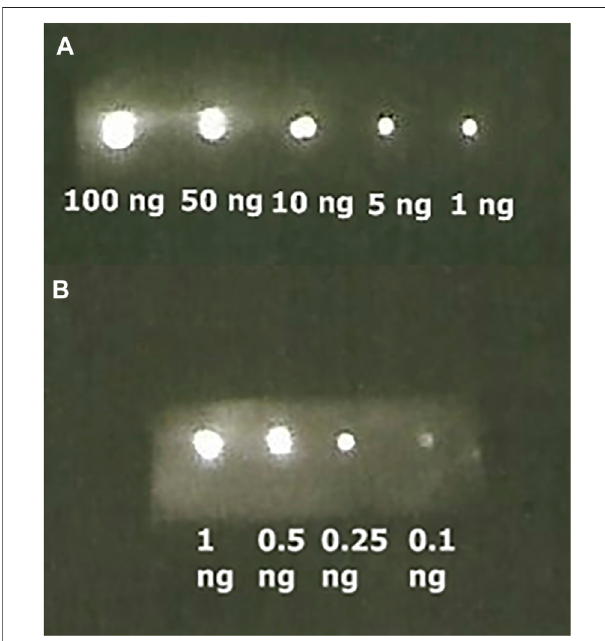
FIGURE 6 | Bioluminescence immunoassay of SARS-CoV-2 Nucleoprotein bound to its respective antibody and revealed withZZ-AmyLuc fusionprotein: (A) from100ngto1 ngexposedduring1min,and (B) from1to 0.10 ng exposed 5 min.